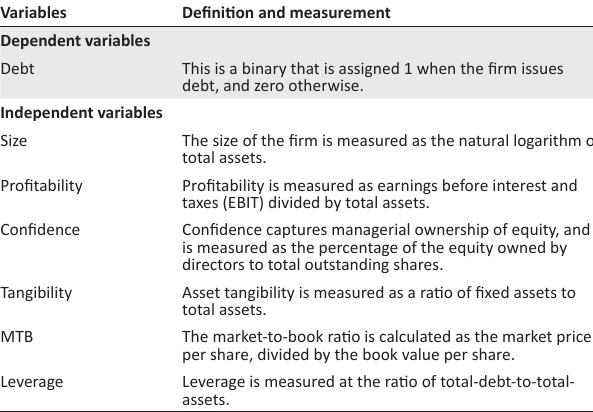
TABLE A1: Definition of